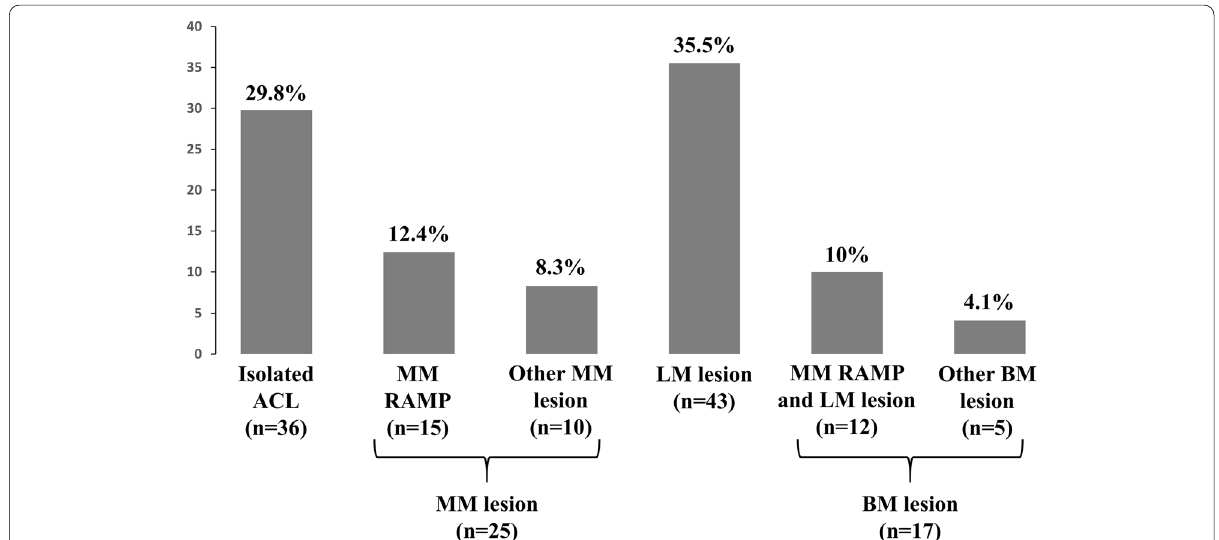
Fig. 2 Prevalence of concomitant meniscal lesion with an ACL injury. Meniscus injuries and specific types of lesions, including ramp lesions, are